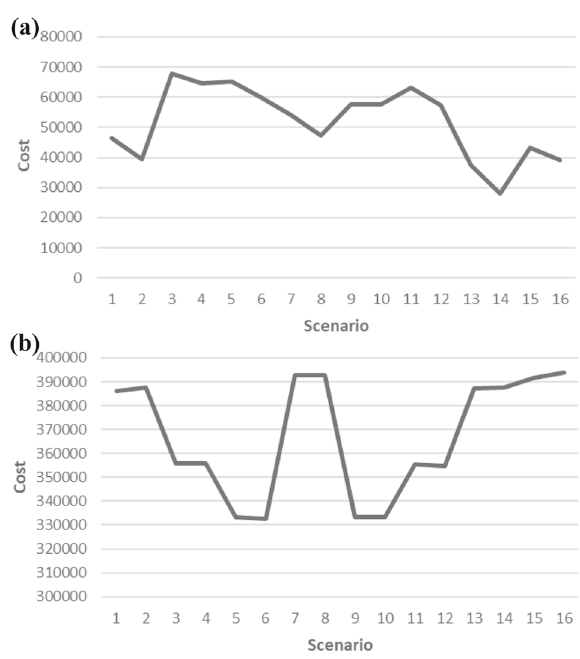
Fig. 8 a Average total penalty cost, b Average total production